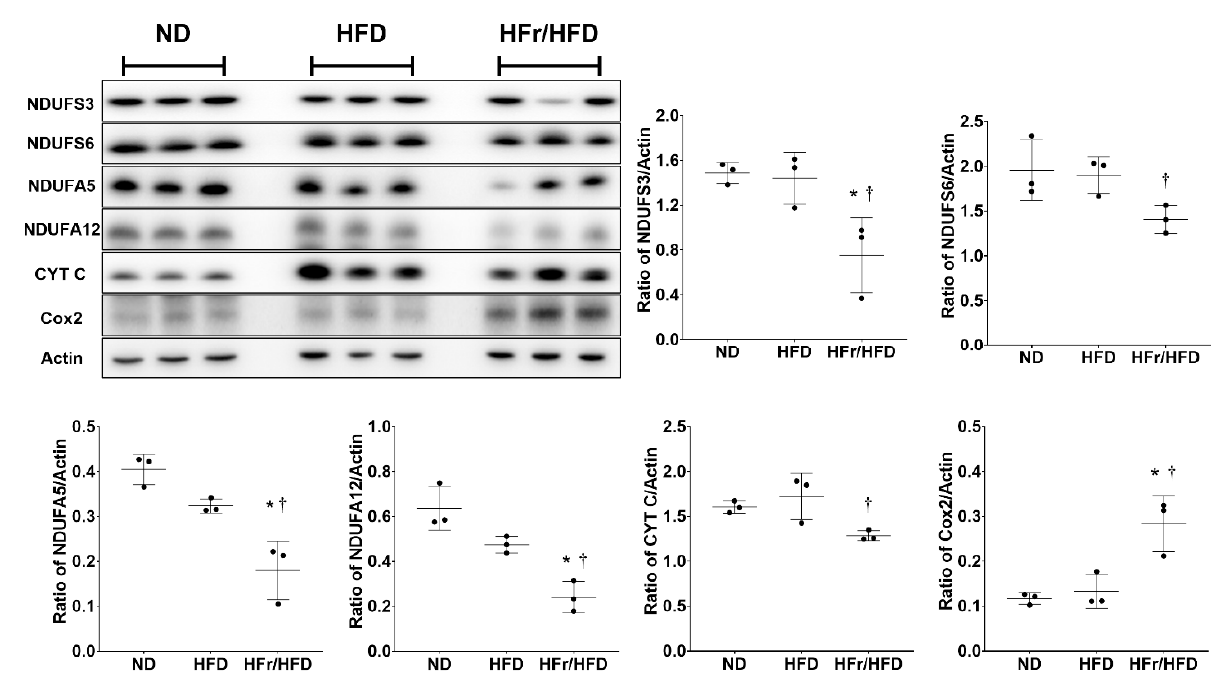
Figure 7. Representative gel photography of immunoblotting assay in liver tissues for the levels of NDUFS3, NDUFS6, NDUFA5, NDUFA12, CYT C, Cox2, and Actin (the internal standard) in the ND, HFD and HFr/HFD groups. Quantification of band intensity represented as ratio to targeting protein over Actin. Data were derived from three mice in each group and presented as mean ± standard deviation. NDUFS3: NADH: ubiquinone oxidoreductase subunits S3, NDUFS6: NADH: ubiquinone oxidoreductase subunits S6, NDUFA5: NADH: ubiquinone oxidoreductase subunits A5, and NDUFA12: NADH: ubiquinone oxidoreductase subunits A12. CYT C: cytochrome C. Cox2: cytochrome C oxidase subunit 2. ND: normal diet group. HFD: high-fat diet group. HFr/HFD: high-fat diet plus 30% fructose in drinking water group. * p < 0.05, versus the ND group; † p < 0.05, the HFr/HFD group versus the HFD group. Note. The original images of immunoblotting assay can be found in the Supplemental Materials: Figure S1.